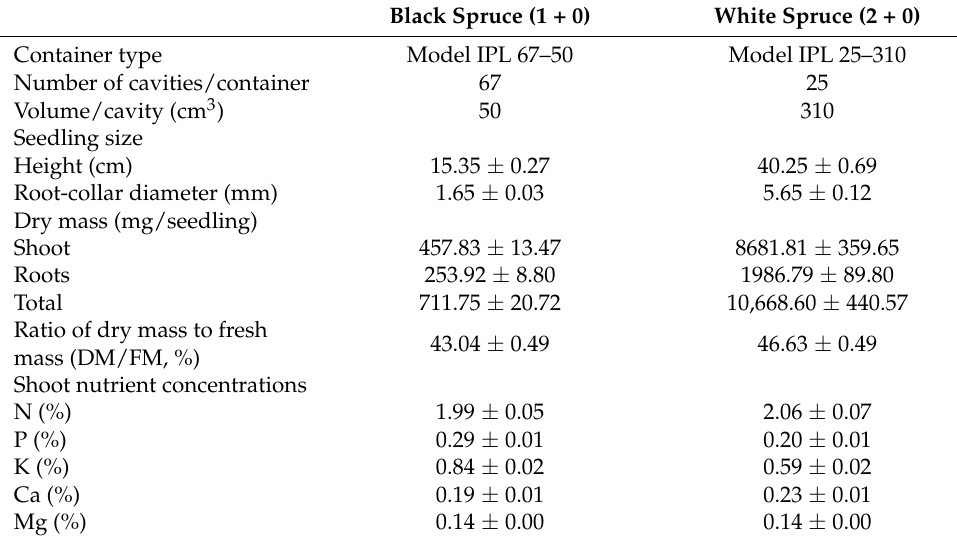
Table 1. Initial morphophysiological characteristics of one-year-old black spruce and two-year-old white spruce seedlings (mean ± SE). Black Spruce (1 + 0) White Spruce (2 + 0) Model IPL 67–50 Model IPL